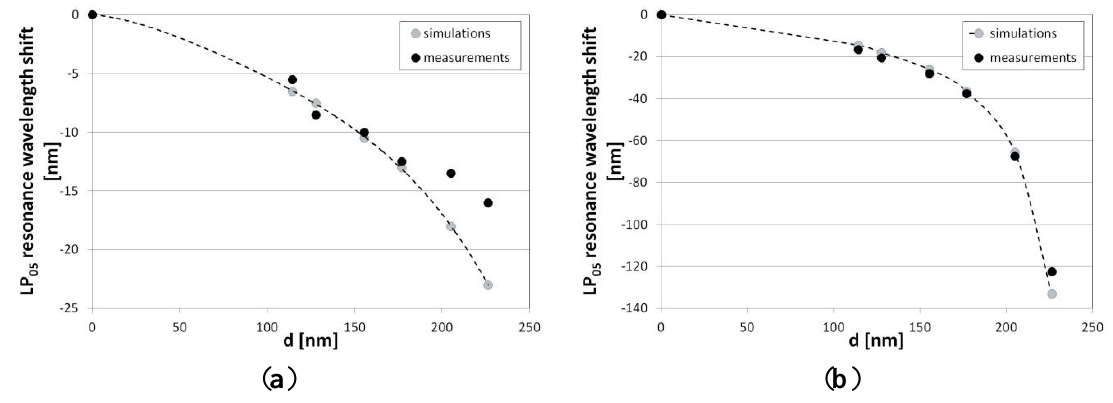
Figure 7. Resonance wavelength shift with n thickness. The n